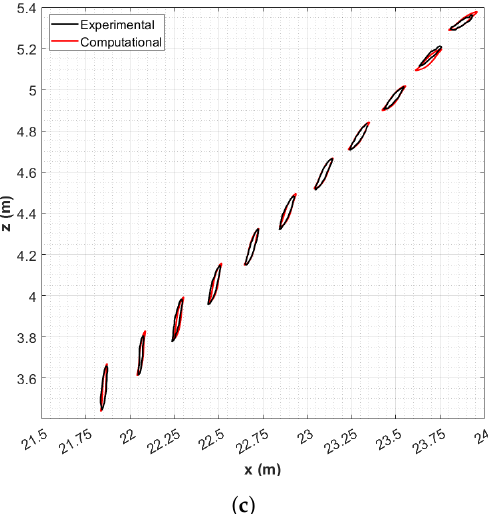
Figure 26. Comparison between computed trajectories of catenary nodes and experimental tracked points for different oscillation periods T = 2.8, 3.5, 5.5 s and amplitude A = 0.125 m for the isolated mooring line without clumped weight. ( a ) T = 2.8 s. ( b ) T = 3.5 s. ( c ) T = 5.5 s.